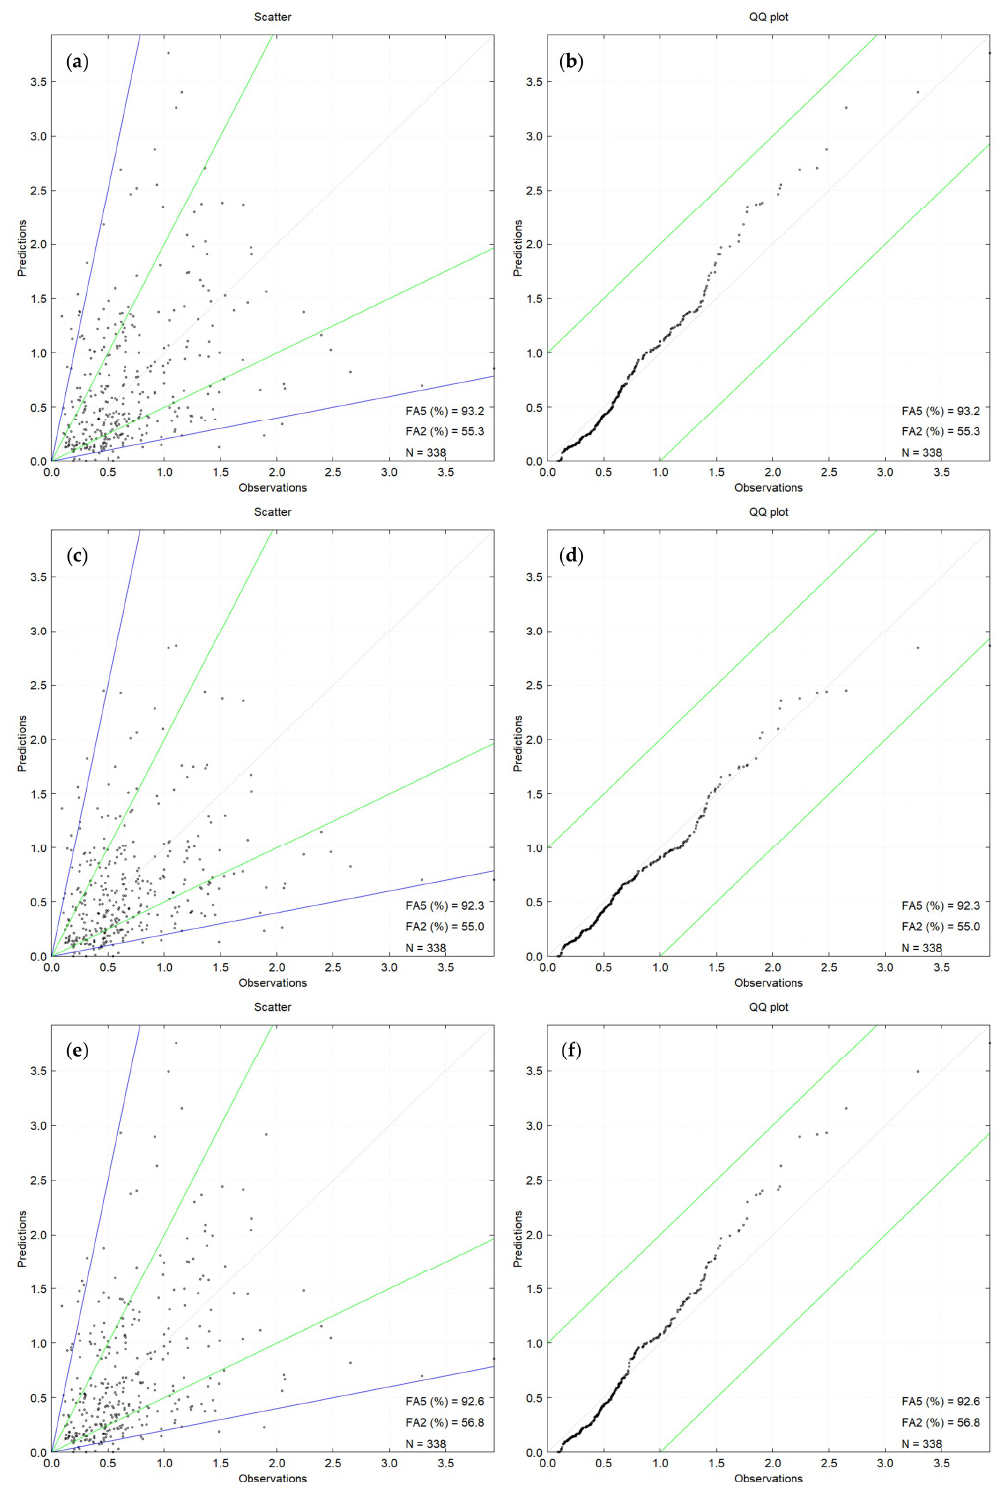
Figure 5. Scatter plots and QQ plots for Kincaid SF 6 best-quality data (μg m −3 ): ( a ) WT plume rise scatter plot; ( b ) WT plume rise QQ plot; ( c ) JJ + RS plume rise scatter plot; ( d ) JJ + RS plume rise QQ plot; ( e ) JJ + JJ plume rise scatter plot; ( f ) JJ + JJ plume rise QQ plot.